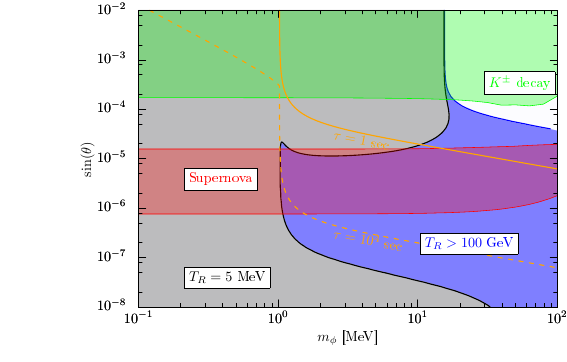
(a) Current cosmological constraints. (b) Future cosmological prospects. Figure 19. The cosmological constraints on the dark scalar model. The gray region shows the most conservative constraint, which is excluded even for an extremely low reheating temperature. The blue region shows the excluded region for the reheating temperature greater than 100 GeV. The white region is cosmologically consistent